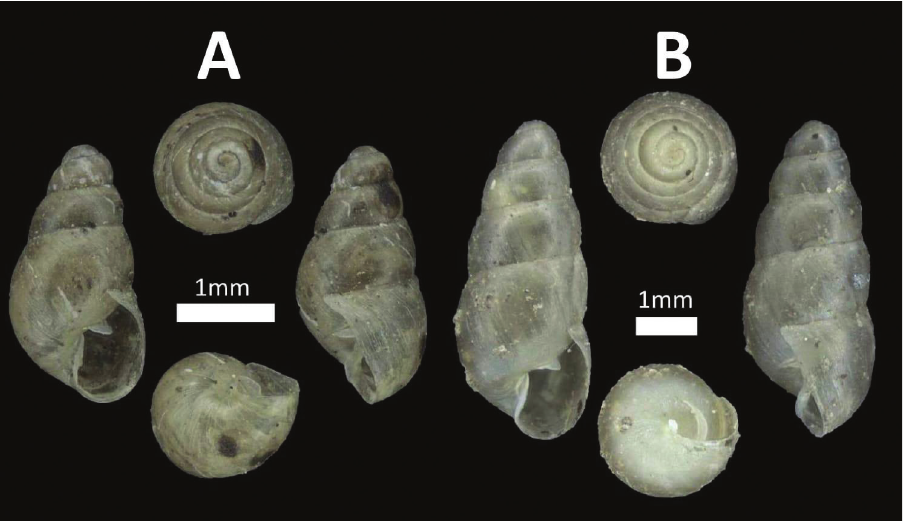
Figure 9. Family Achatinellidae. A Elasmias manilense (BOR/MOL 12356) B Tornatellinops moluccana (BOR/MOL